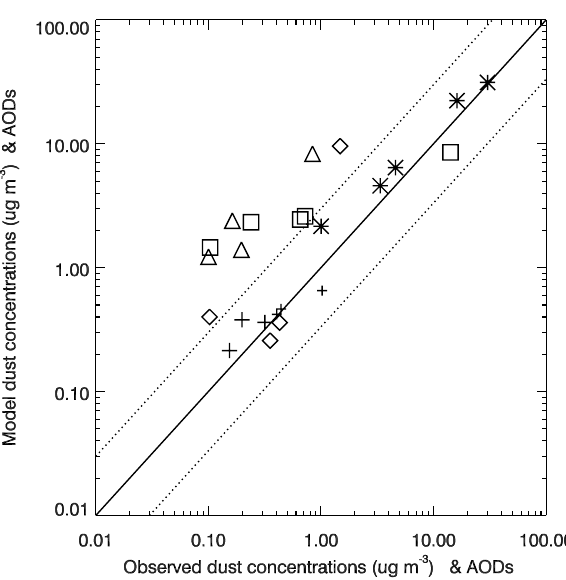
Fig. 10. Comparison of modelled (HadGEM2-ES) and observed near surface dust concentrations and total aerosol optical depths (AODs) at 440nm. Observed optical depths are from AERONET stations in dust-dominated regions and concentrations from stations of the University of Miami network (with thanks to J. M. Prospero and D. L. Savoie). Symbols indicate: crosses – AODs, stars – At- lantic concentrations, squares – N Pacific concentrations, triangles – S Pacific concentrations, diamonds – Southern Ocean concentra-